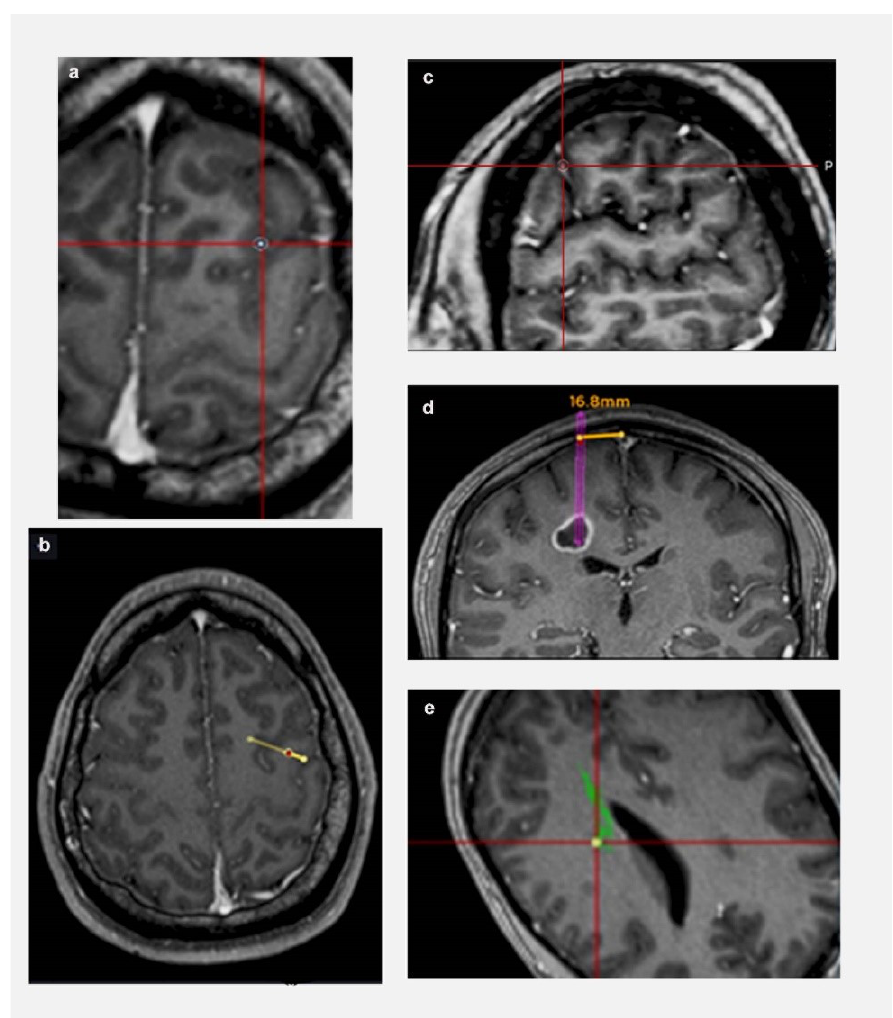
Figure 1. Defining relationship to critical neurovascular structures. ( a ) Sulcal transgression of trajectory; ( b ) Transgression of eloquent cortex by trajectory (arrow represents central sulcus); ( c ) Proximity to vessel—Zone 1 (the rim represents 3 mm safety margin); ( d ) Proximity to midline—trajectory is 16.8 mm from midline (Zone 1 < 20 mm from midline); ( e ) Proximity to CST—Zone 1 (the rim represents 3 mm safety margin).